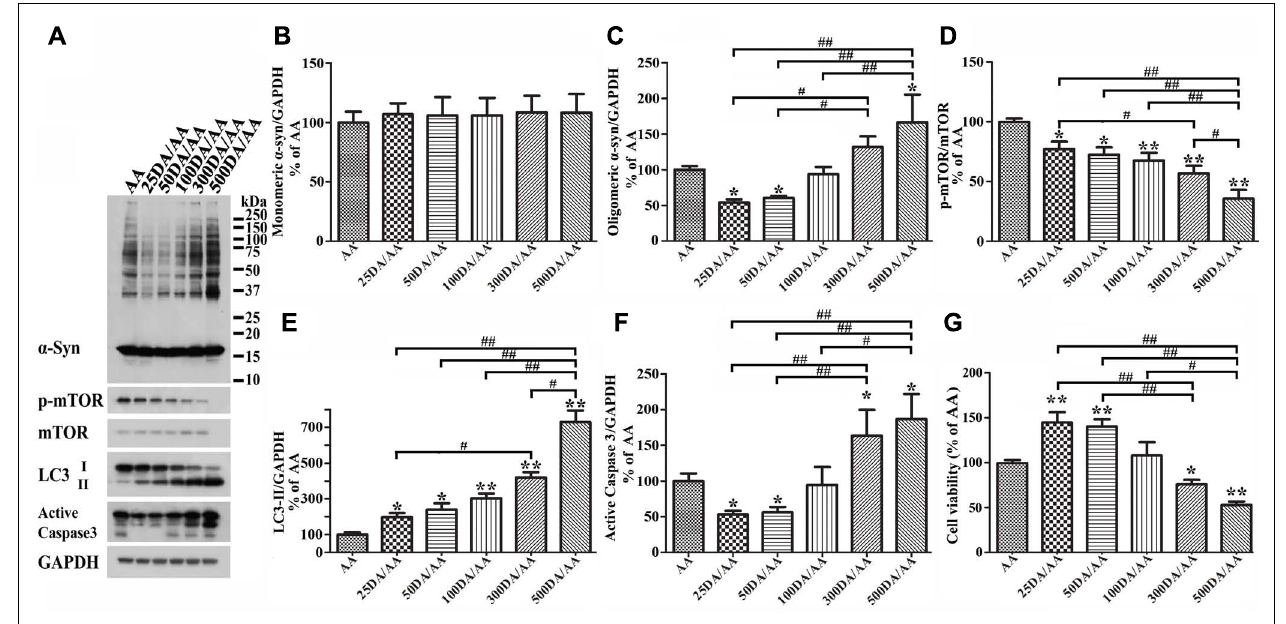
FIGURE 8 | Biphasic effects of DA exposure on α -syn oligomer accumulation and cell survival. 3D5/DAT cells seeded on 48-well plates with 8 days of differentiation and α -syn induction were exposed to AA plus 0, 25, 50, 100, 300, or 500 μ M DA for 60 h and referred to as AA, 25DA/AA, 50DA/AA, 100DA/AA, 300DA/AA, 500DA/AA, respectively.They were used for western blotting with antibodies raised to α -syn, p-mTOR, mTOR, LC3, active caspase 3, and GAPDH and for calcein assay. (A) Western blotting of cell lysates with antibodies to α -syn, p-mTOR, mTOR, LC3, active caspase 3, and GAPDH. (B–F) Bar graphs summarized data from quantitation of the immunoreactivities of various proteins labeled in (A) with GAPDH normalization and that from additional experiments. Results showed that co-treatment of cultures